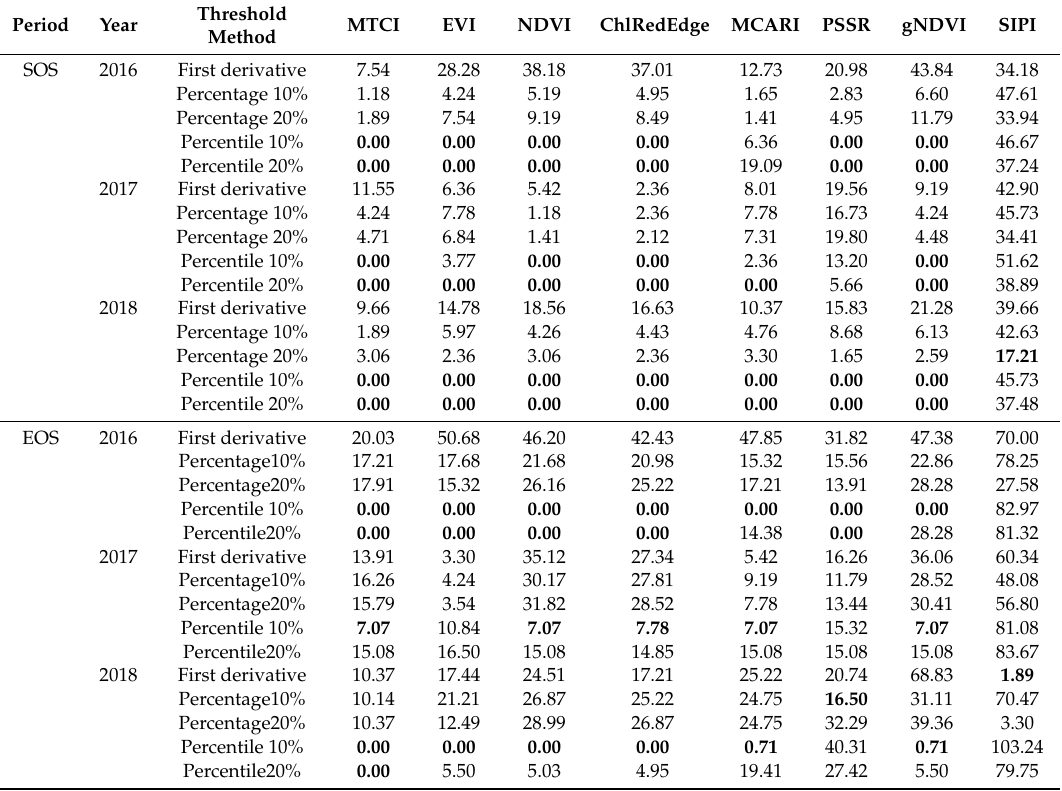
The 20% and 10% percentile were the best threshold for estimating GPP metrics for SOS. The distance between the EOS of GPP and EOS of VIs di ff ered the least using a 10% percentile threshold (Table 5). Table 5. Distance, in days, to the 1:1 line between the start of the season (SOS) and the end of the season (EOS) derived from Gross Primary Productivity (GPP) and VIs (see VIs definitions in Table 1) and for each threshold method. The shortest distances are in